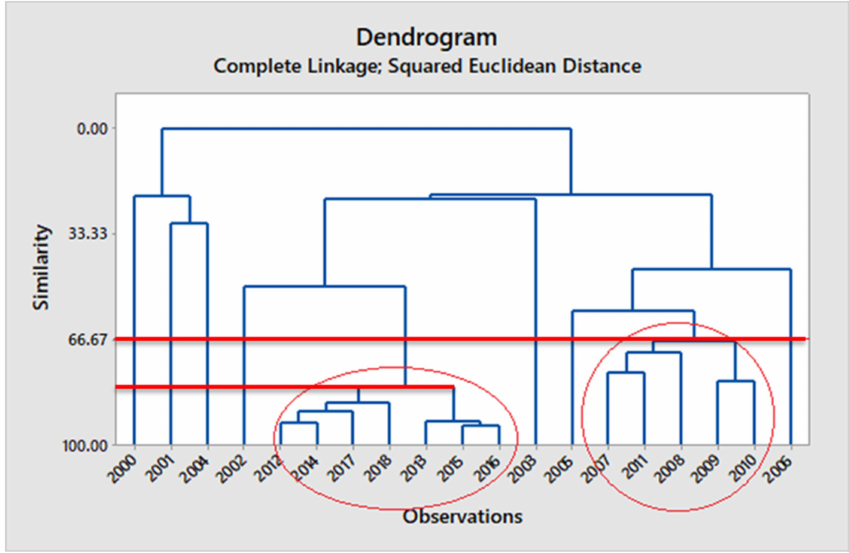
Figure 6. Years grouped according to the profile of themes (source: